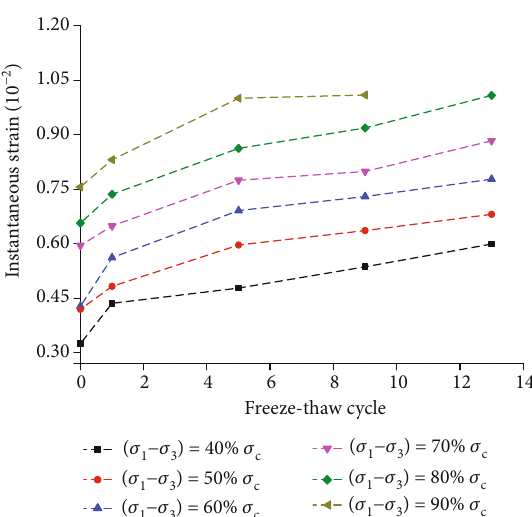
Figure 11: Curves of the instantaneous strain versus the number of freeze-thaw cycles at various stress levels under 2 MPa of con fi ning pressure.